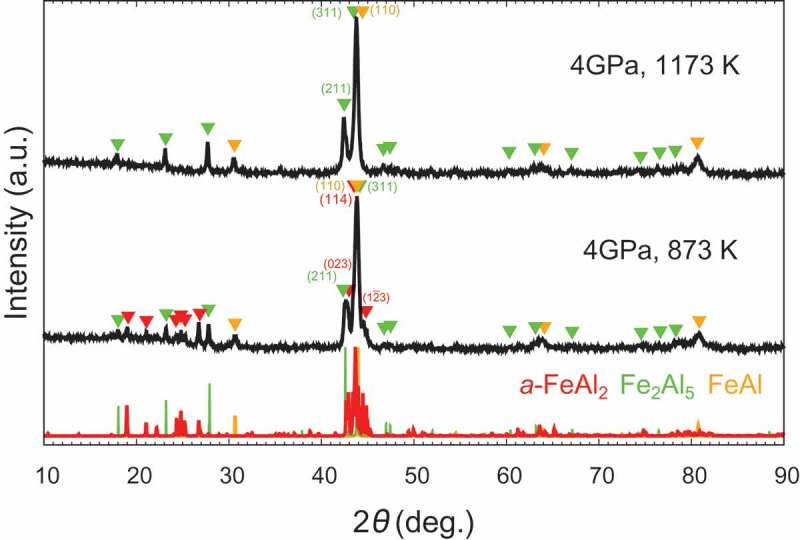
X-ray diffraction patterns with Cu Kα of the sample synthesized at (top) 4 GPa and 1173 K, and (bottom) 4 GPa and 873 K. The direct decomposition from a-FeAl2 to FeAl and Fe2Al5 was observed at 4 GPa and 873 K. t-FeAl2 was not observed over the entire temperature range.